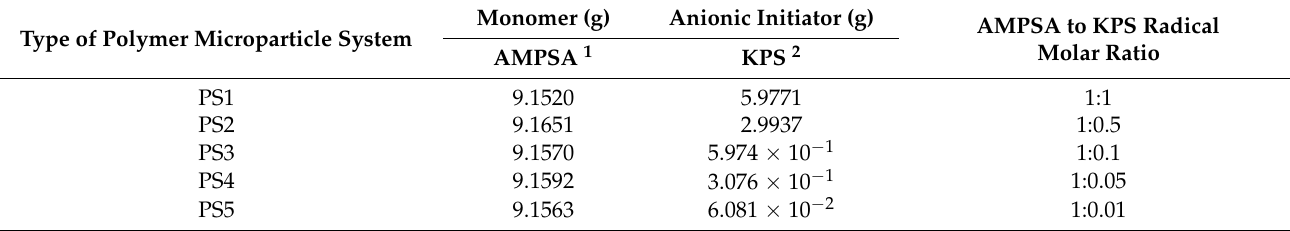
Table 1. Compositions of PS1, PS2, PS3, PS4, and PS5 microparticles and the molar ratio of monomer to sulfate radicals. Type of Polymer Microparticle